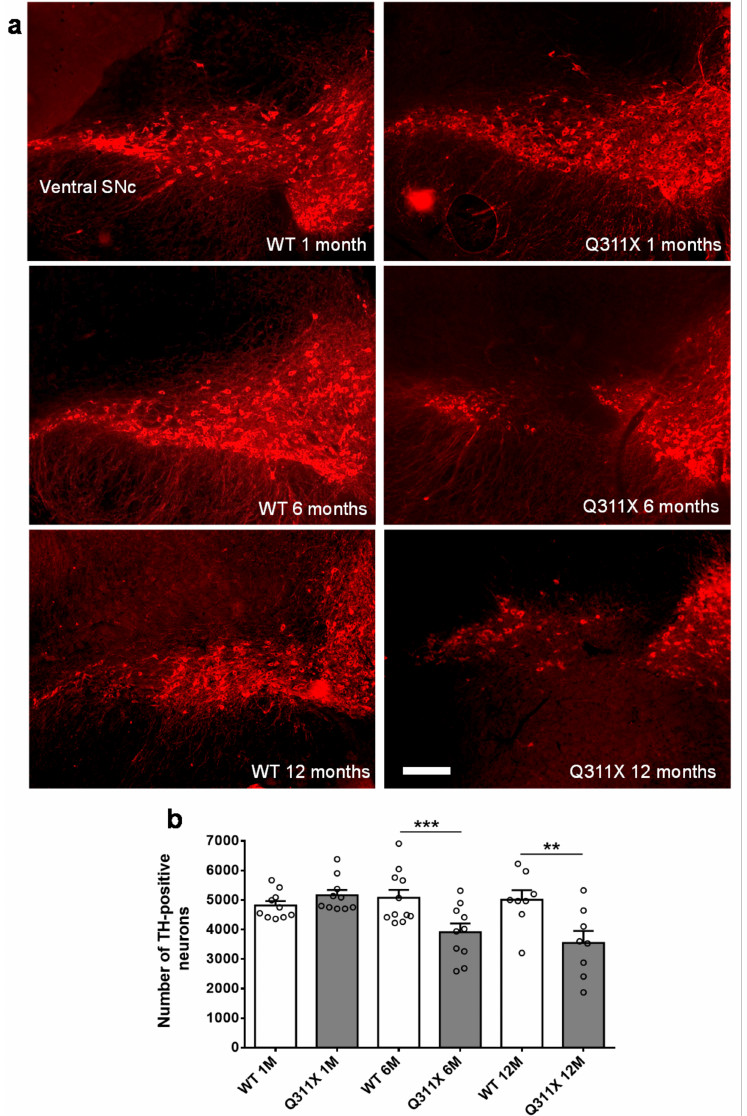
Figure 1. ParkinQ311X mice display early SNc DA neuronal loss. ( a ) Representative immunofluores- cence images showing tyrosine hydroxylase (TH) labeling in the SNc of WT and parkinQ311X mice at 1, 6, and 12 months of age. At 6 and 12 months of age, a loss of DA neurons and dopaminergic dendrites in the pars reticulata of the substantia nigra becomes apparent. ( b ) The graph presents a stereological count of DA neurons. Data are mean ± SEM of n mice: WT 1 month (1M) 4817 ± 146 n = 10, parkinQ311X mice (1M) 5160 ± 182 n = 10, WT 6 months (6M) 5075 ± 270 n = 11, park- inQ311X mice (6M) 3913 ± 293 n = 10, WT 12 months (12M) 5009 ± 326 n = 8, parkinQ311X mice (12M) 3546 ± 406 n = 8; one-way ANOVA followed by Sidak’s multiple comparisons test WT 6M vs. ParkinQ311X 6M *** p < 0.001, WT 12M vs. ParkinQ311X 12M ** p < 0.01. Bar is 100 µ